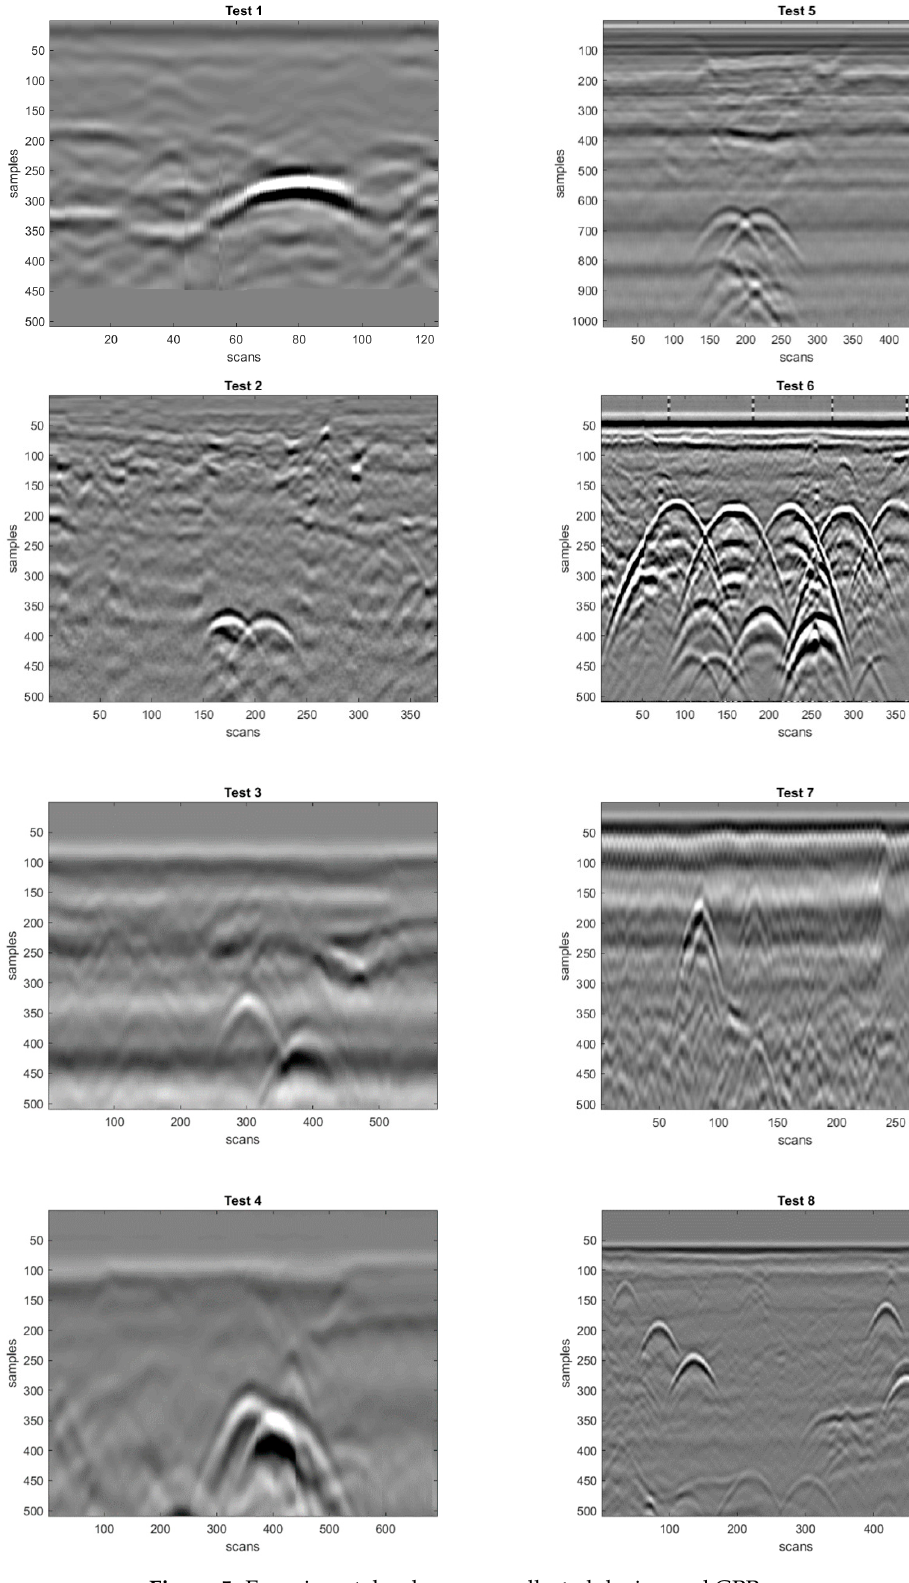
Figure 6. Synthetic radargrams generated using the electromagnetic simulator gprMax.